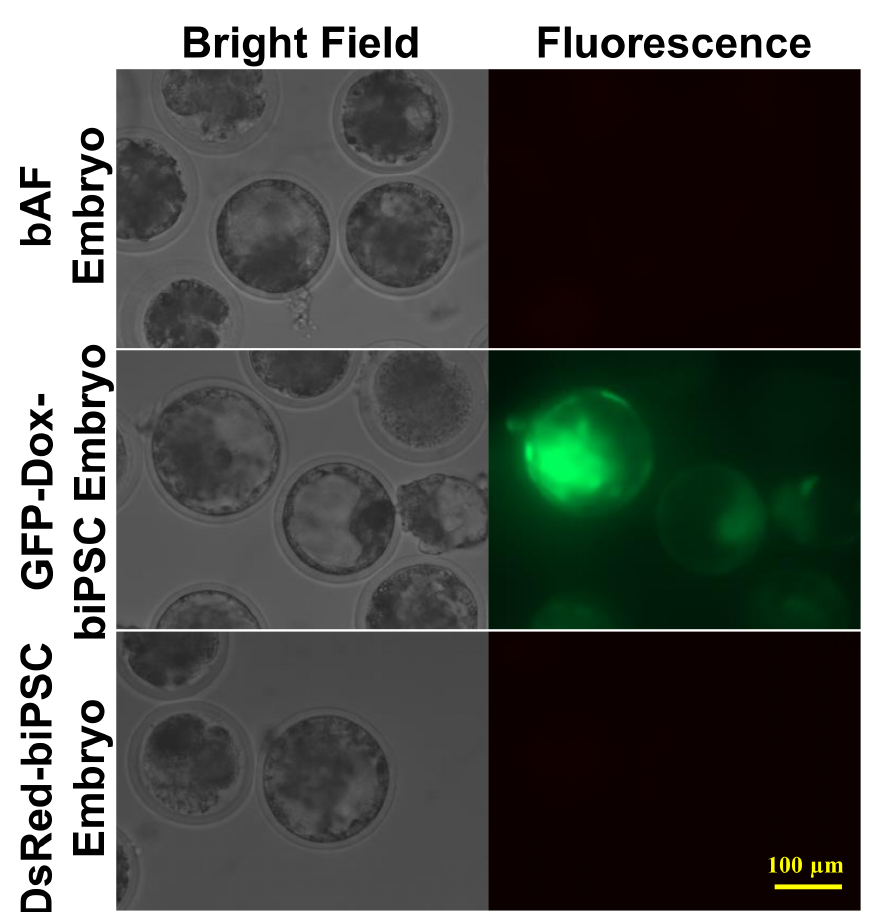
Figure 6. Blastocysts cloned from biPSCs. Blastocysts using bAF as nuclear donors ( upper panel ); GFP-Dox-biPSC as nuclear donors ( middle panel ), Dox was added into the embryo culture medium 6 days after activation of cloned embryos to induce the GFP expression; and DsRed-biPSC as nuclear donors ( lower panel ). Bar = 100 µ